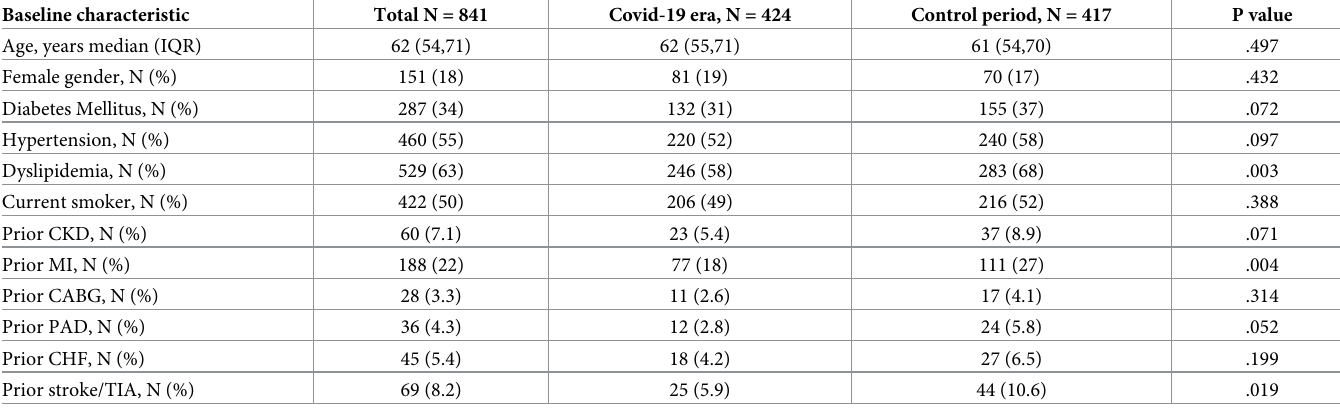
Table 1. Baseline characteristics of STEMI patients before and during the Covid-19 pandemics.